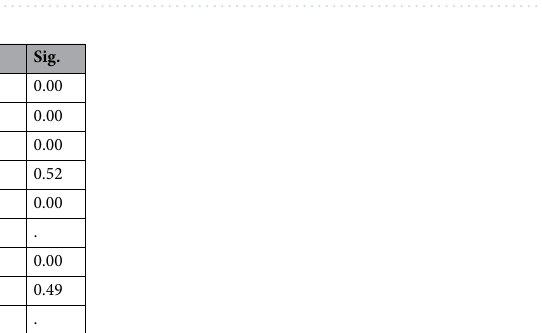
Figure 1. Pictorial representation of P. chrysogenum Snef1216 and its influence upon the entire body of second- stage juveniles (J2s). Whereas; ( A and B ) Pure fungal colony of P. chrysogenum Snef1216, ( C ) Microscopic image of P. chrysogenum , ( D and E ): Living juveniles, ( F ) Natural death of juvenile, ( G and H ): Juveniles death due to P. chrysogenum Snef1216.